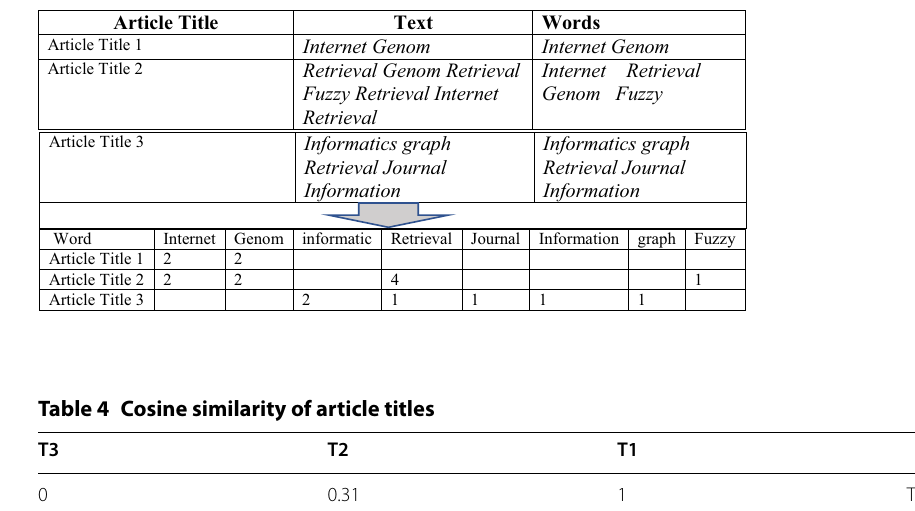
Table 3 Incidence of words and matrices for the article titles